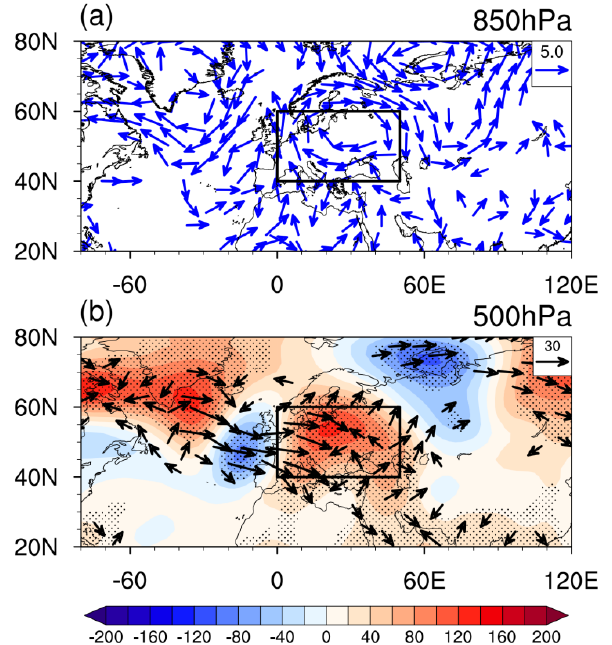
Figure 2. ( a ) Anomalies of 850-hPa horizontal winds (unit: m · s − 1 ) in June of 2019 relative to 1948–2019. Only anomalies exceeding one standard deviation are shown. ( b ) Anomalies of 500-hPa geopotential height (shadings, unit: gpm) and wave activity fluxes (vectors, unit: m 2 · s − 2 ) derived from Takaya and Nakamura [32,33] in June of 2019 relative to 1948–2019. Stippling regions in ( b ) represent 500-hPa geopotential height anomalies exceeding one standard deviation.